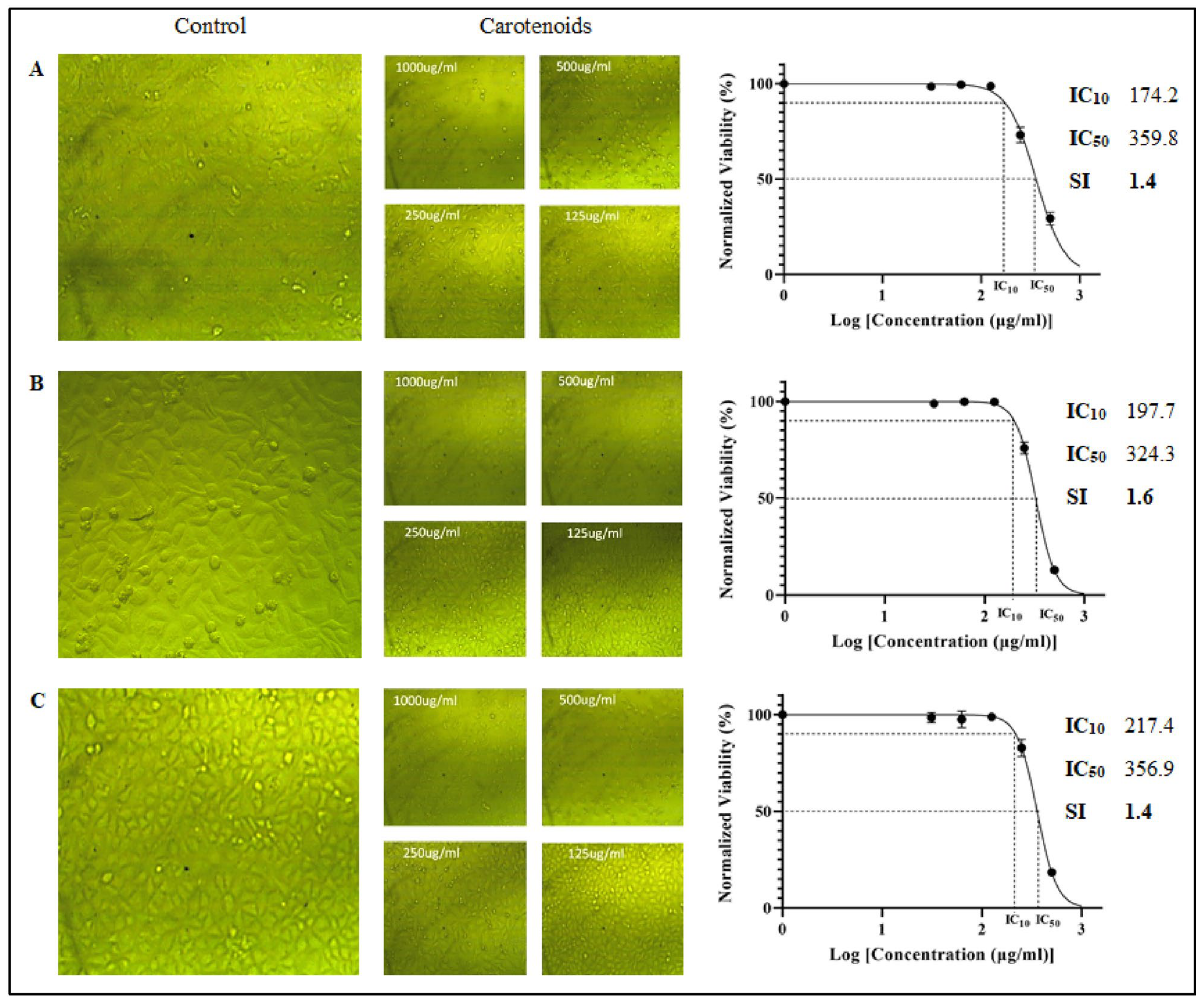
Figure 13. Imaging and IC 10 and IC 50 estimations of ( A ) MCF-7, ( B ) Caco-2 and ( C ) Hela cancer cell lines treated with different concentrations of Kocuria sp. RAM1 carotenoids by the in vitro cytotoxicity MTT test. GraphPad Prism 9 was used for